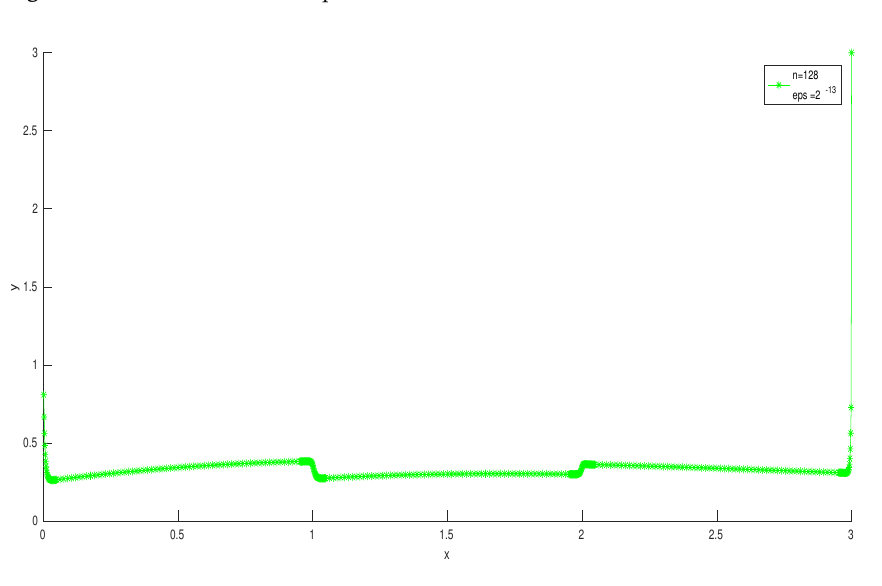
Figure 1. The solution for Example 1.